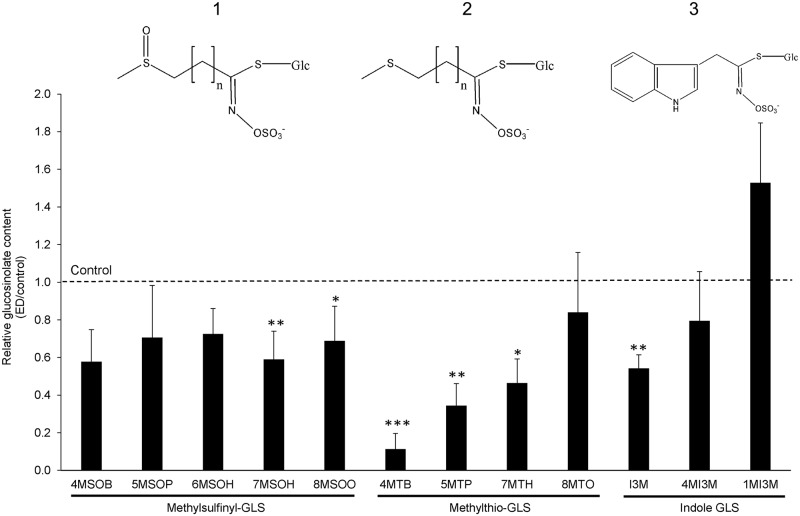
Glucosinolate content in rosette leaves after extended darkness (ED).Plants were grown for six weeks under short day condition and transferred to darkness for 7 d. Glucosinolate content of rosette leaves was measured via LC-MS. Values are means of three to four biological replicates (error bars represent the standard deviation) and Student’s T-test shows *P < 0.05; ** P < 0.01; ***P < 0.001. 1: general structure of methylsulfinyl-GLS; 2: general structure of methylthio-GLS; 3: structure of I3M. 4MSOB (4-Methylsulfinylbutyl-GLS); 5MSOP (5-Methylsulfinylpentyl-GLS); 6MSOH (6-Methylsulfinylhexyl-GLS); 7MSOH (7-Methylsulfinylheptyl); 8MSOO (8-Methylsulfinyloctyl); 4MTB (4-Methylthiobutyl-GLS); 5MTP (5-Methylthiopentyl-GLS); 7MTH (7-Methylthioheptyl-GLS); 8MTO (8-Methylthiooctyl-GLS); I3M (Indol-3-ylmethyl-GLS); 4MI3M (4-Methoxy-indol-3-ylmethyl-GLS); 1MI3M (N-Methoxy-indol-3-ylmethyl-GLS).